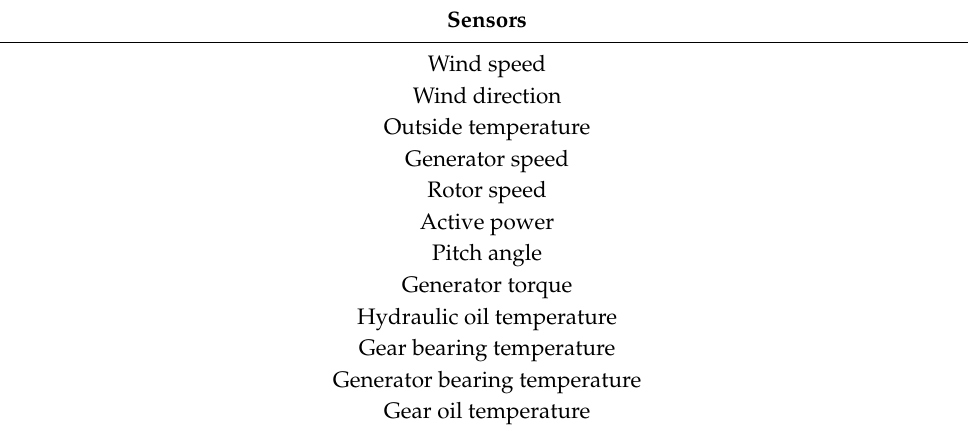
Table 1. SCADA sensors.